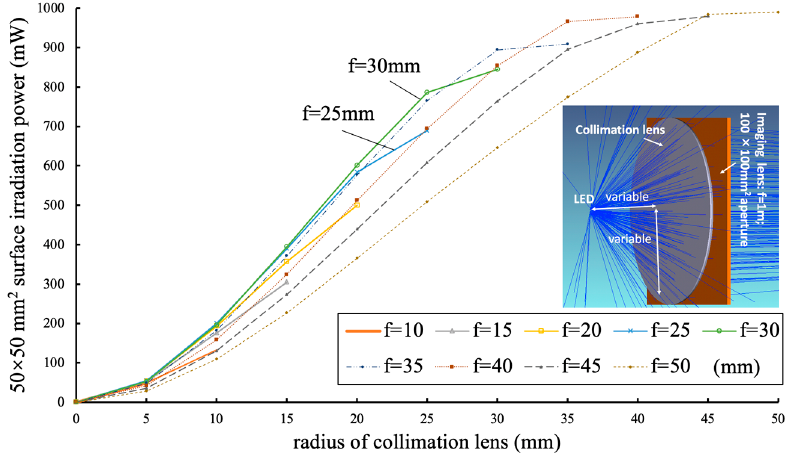
Figure 2. Irradiation power of variable collimation lens in single LED-OWPT.